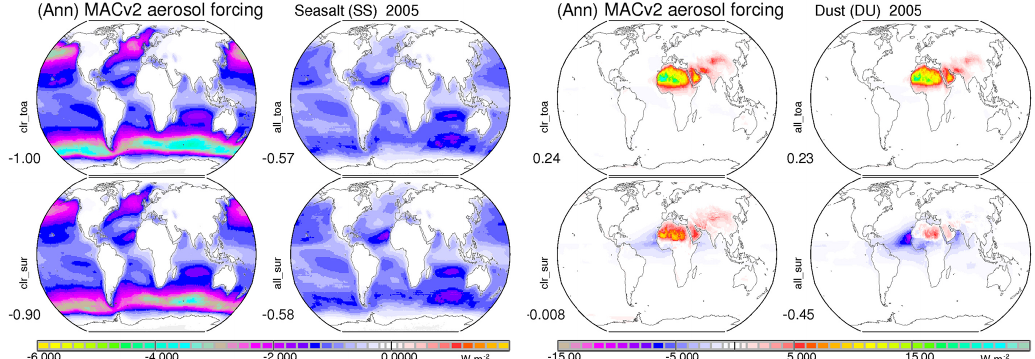
Figure E7. Annual maps for present-day TOA radiative effects of coarse-mode sea salt (SS, left frame) and coarse-mode mineral dust (DU, right block) for clear-sky (left column) and all-sky conditions (right column) both at the TOA (top row) and surface (bottom row). Blue to purple colors indicate a cooling and red to yellow and green colors show a warming. Values below the labels are global averages. Note that the color scale for sea salt is 10 times smaller than the color scale for dust.